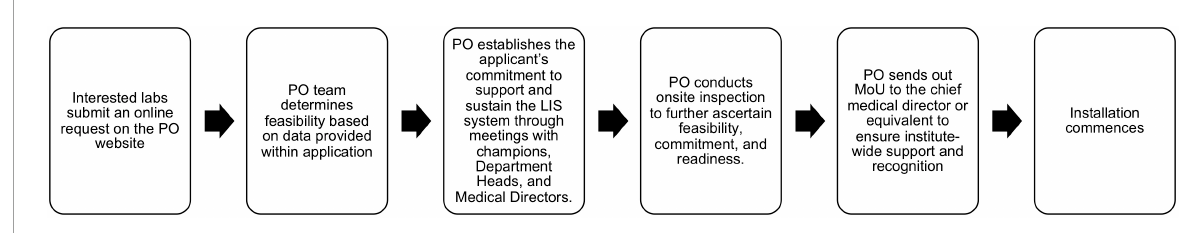
FIGURE1 Flow chart illustrating process for vetting laboratories interested in LIS